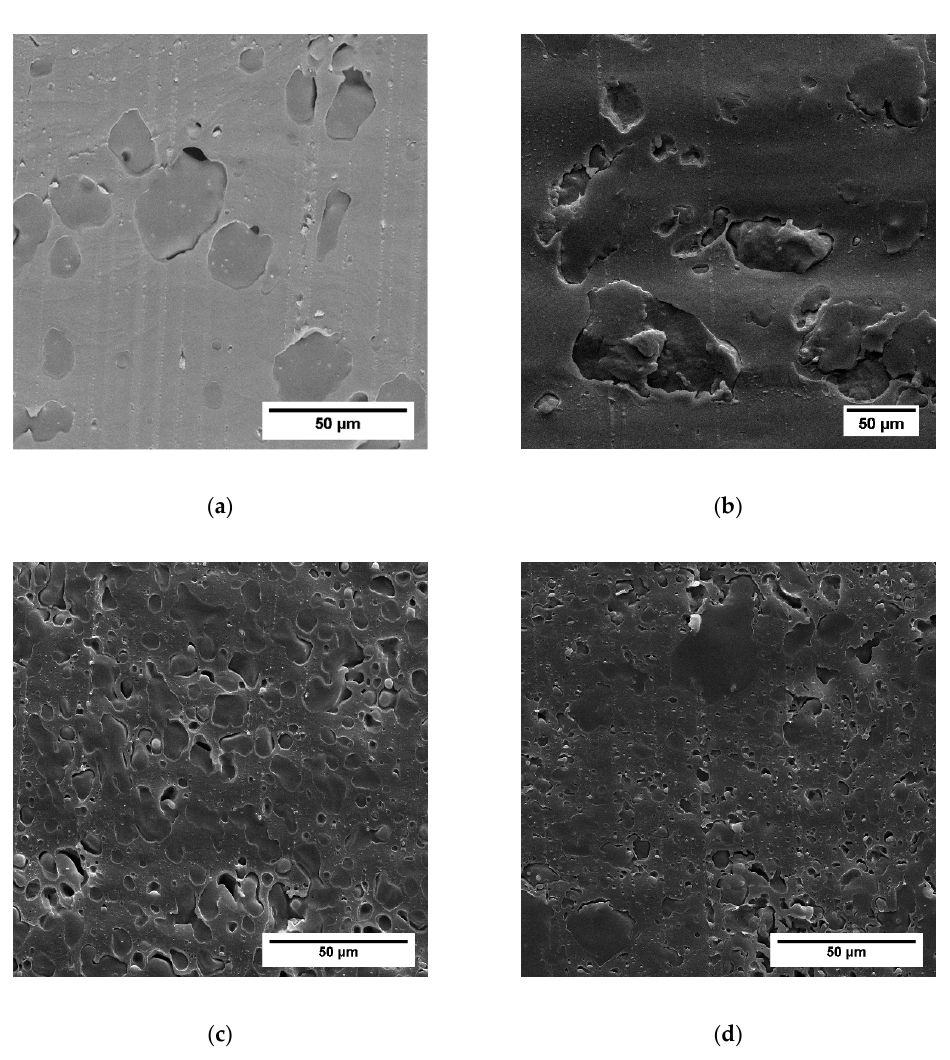
Figure 6. Cryo-sliced surfaces of the samples without soybean oil (SBO). ( a ) Without EMAGMA and Tert-butylperoxy 2-ethylhexyl carbonate (TBEC), ( b ) with 1 phr TBEC, ( c ) with 5 pph EMAGMA, and ( d ) with 5 pph EMAGMA and 1 phr